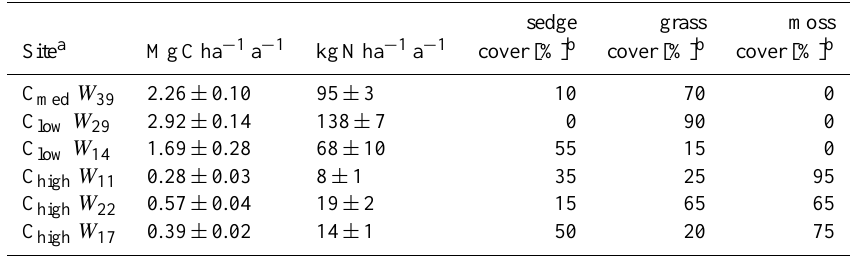
sedge grass moss